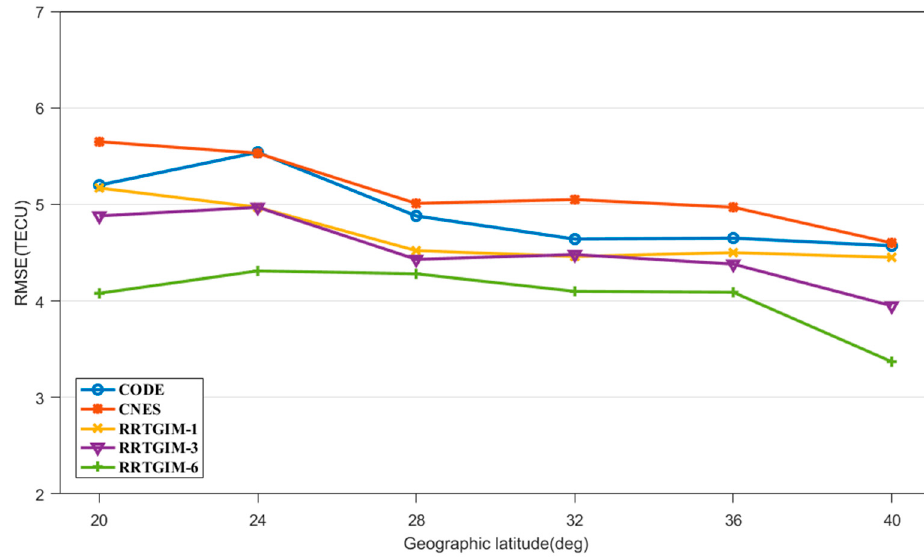
Figure 15. Latitudinal variation of RMSE errors of the VTEC products.